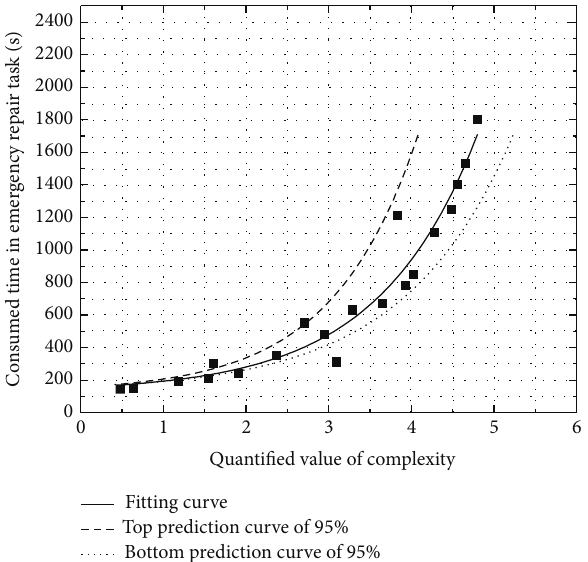
Figure 6: Complexity quantification based on group AHP weight-